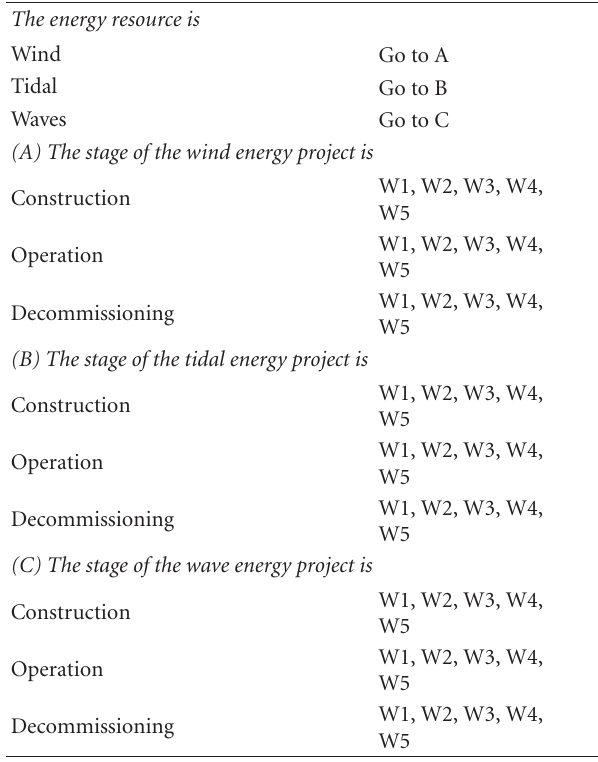
Table 12: Component decision tree for impacts on marine mam- mals. The key is followed to obtain a recommended suite of monitoring